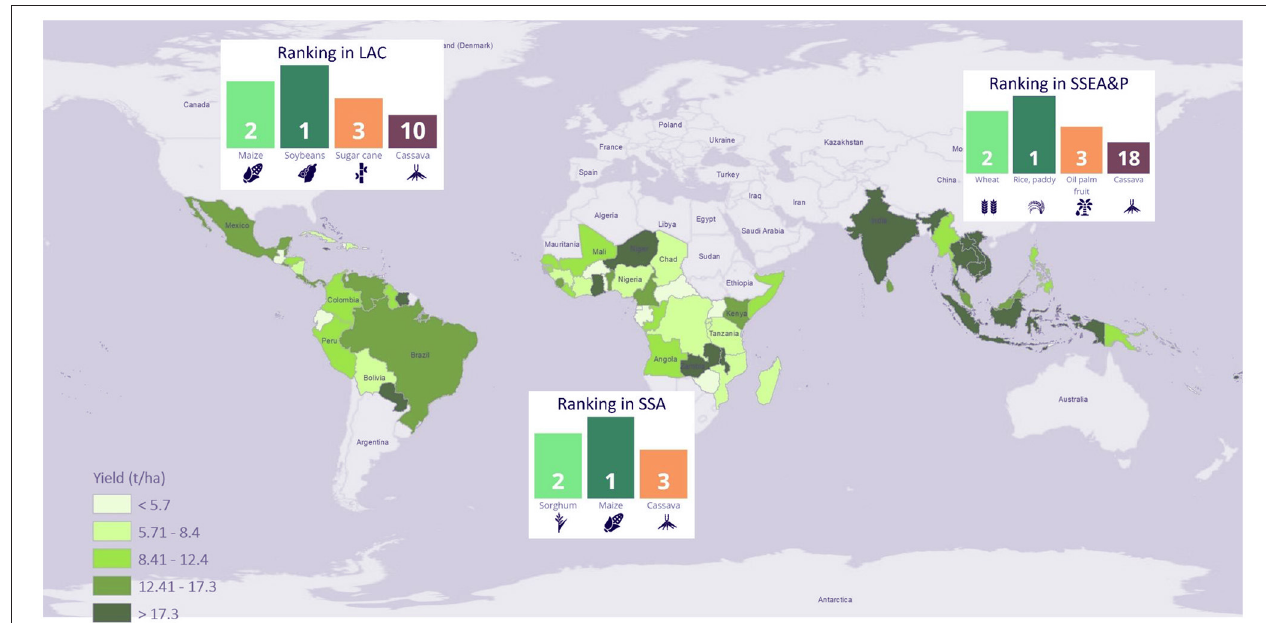
FIGURE 1 | Yield map per country and regional rankings on cassava relevance by hectares harvested 2019. SSA, Sub-Saharan Africa; SSEA and P, South and Southeast Asia and the Pacific; LAC, Latin America and the Caribbean.